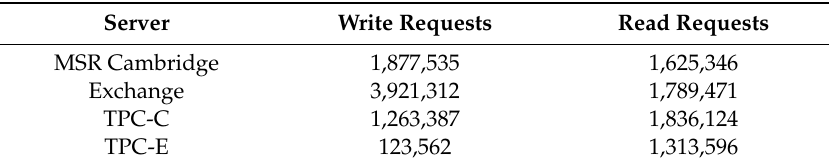
Table 5. The number of operation requests in each